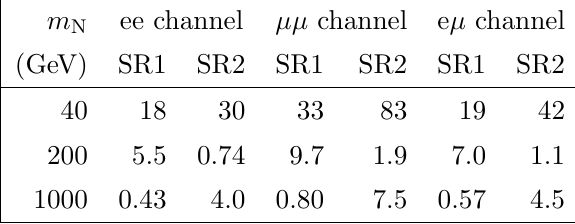
Table 6 . Numbers of expected signal events passing the selection requirements. The matrix element squared is assumed to be 1 10 (cid:0) 4 , 1 10 (cid:0) 2 , and 1 for m N = 40, 200, and 1000 GeV, (cid:2) (cid:2)